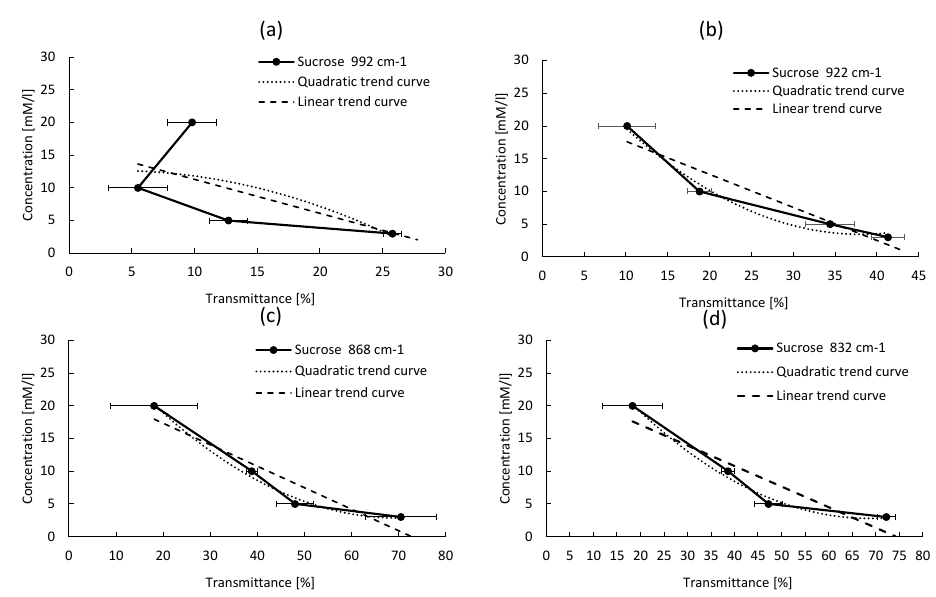
Figure 12. Sucrose absorption intensity versus its concentration for different peaks, for the absorption peaks at ( a ) 992 cm − 1 , ( b ) 922 cm − 1 , ( c ) 868 cm − 1 , ( d ) 832 cm − 1